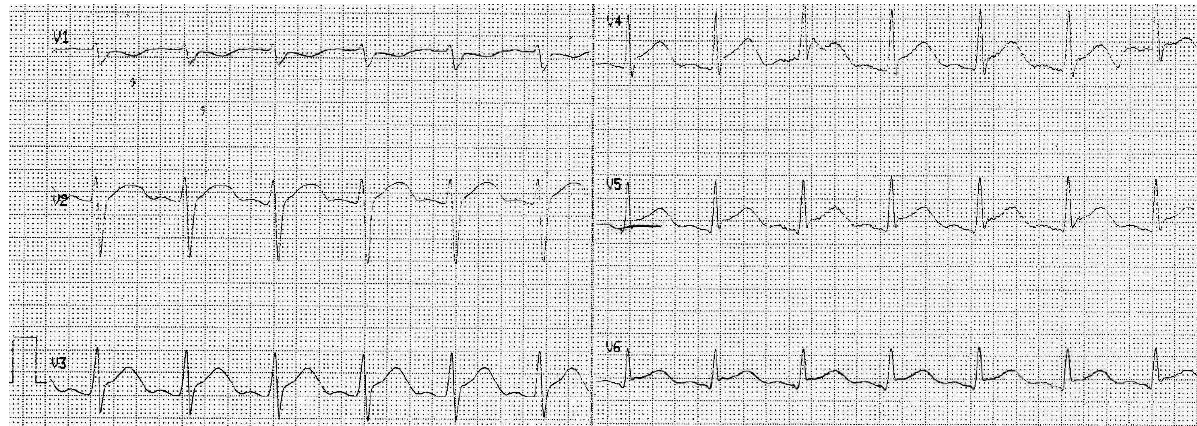
Figure 2. ECG recording on the 3rd day of hospitalization.